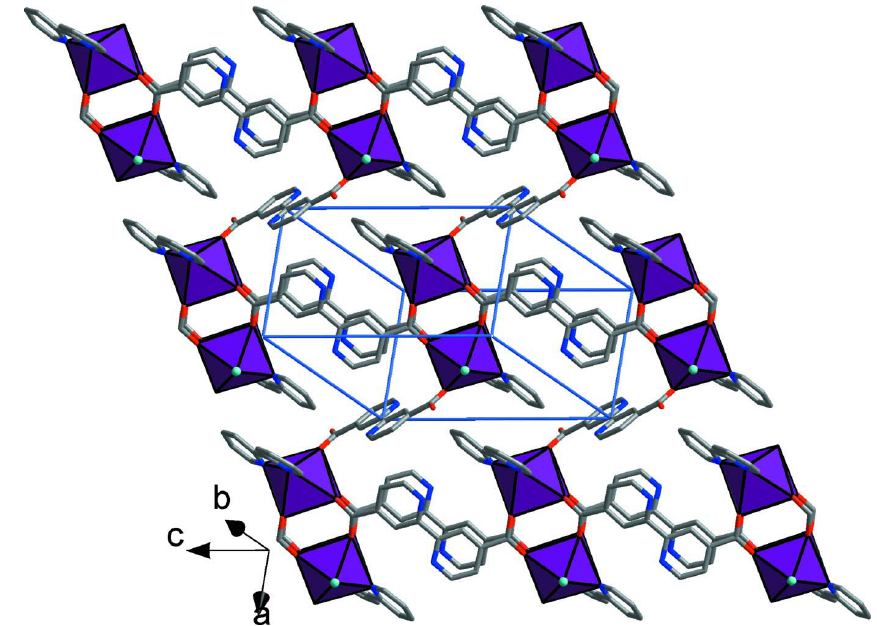
Figure 3 A view of the layer network of the title compound. (Key: auqa sphere: water molecules; purple polyhedra: Nd) Hydrogen atoms are omitted for